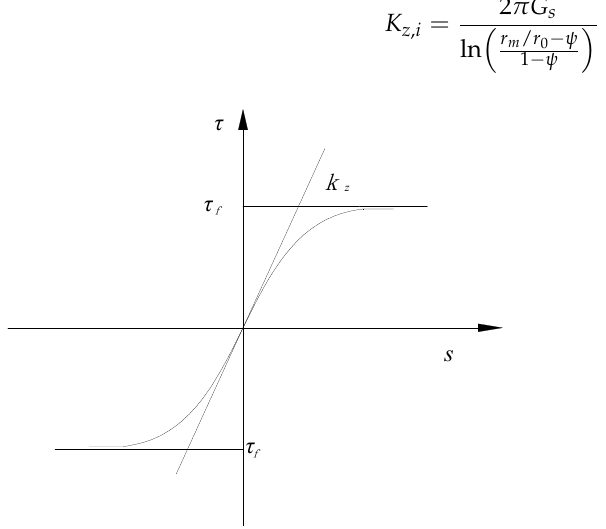
Figure 2. Schematic diagram of Kraft pile–soil interface model.